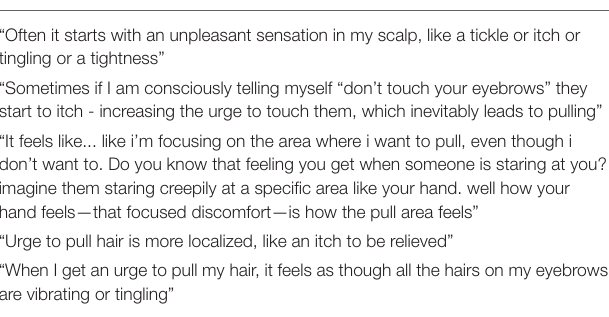
TABLE 5 | Examples of participant comments on itches or focused sensations associated with hair